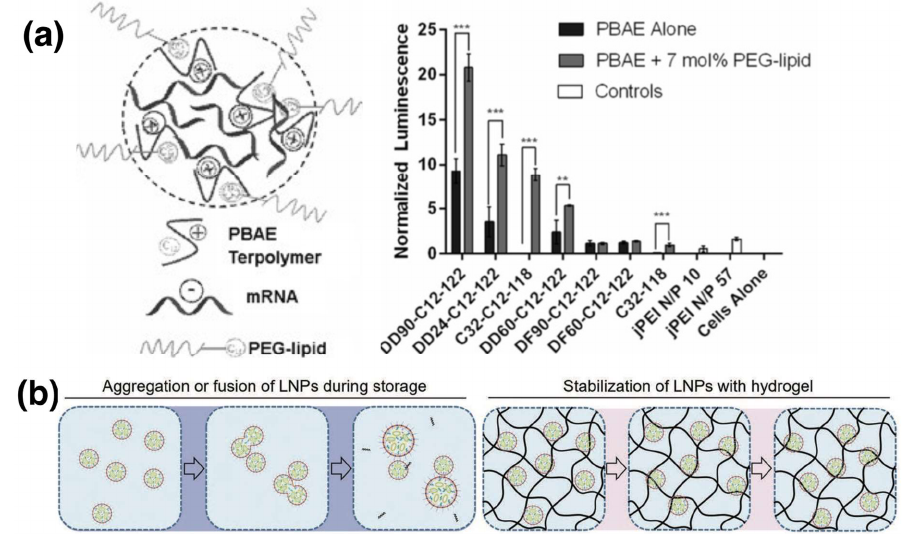
Figure 6. Schematic illustration of polymer-lipid hybrid strategies. ( a ) Polymer–lipid nanoparticles formed with PBAE and PEG-lipid with their stability verified by luminescence level, reproduced with permission [67]; ( b ) stabilization mechanism of mRNA–LNP injected in hyaluronan hydrogel [68]. ** p < 0.01, *** p <